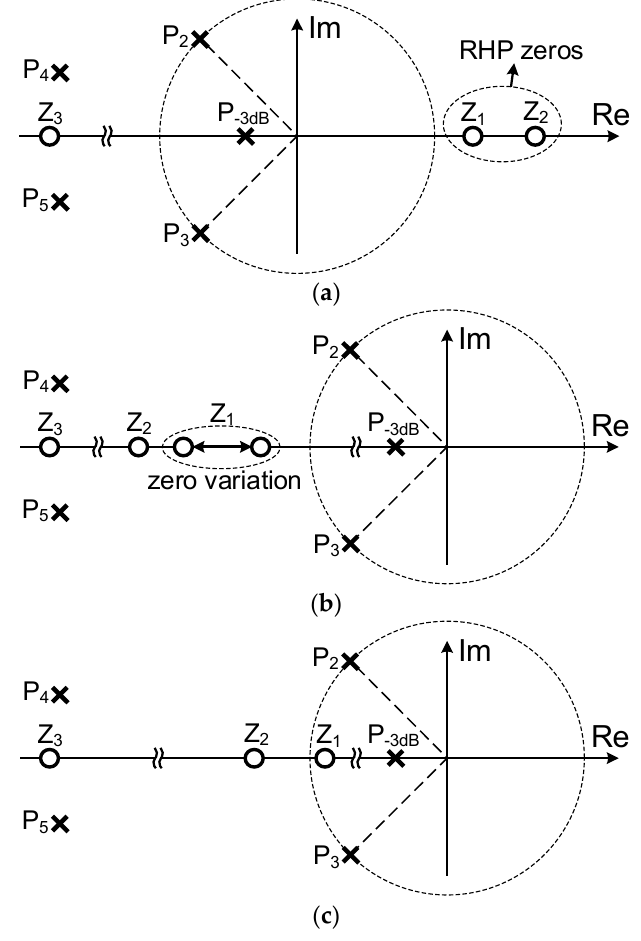
Figure 6. Pole-zero locations of the LDOs. ( a ) Conventional LDO with NMC [17]; ( b ) active-feedback compensation LDO without current-reuse feedforward paths; and ( c ) with current-reuse feedforward paths.